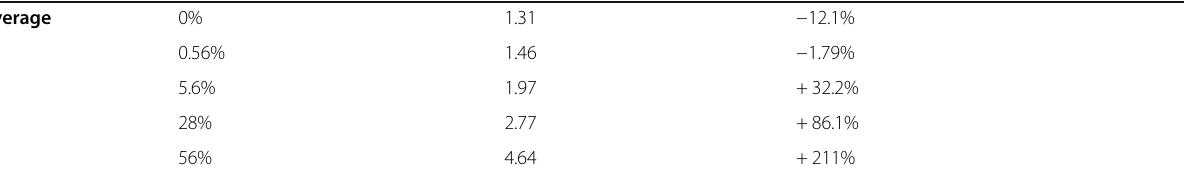
Table 1 Summary of results (Continued) Average